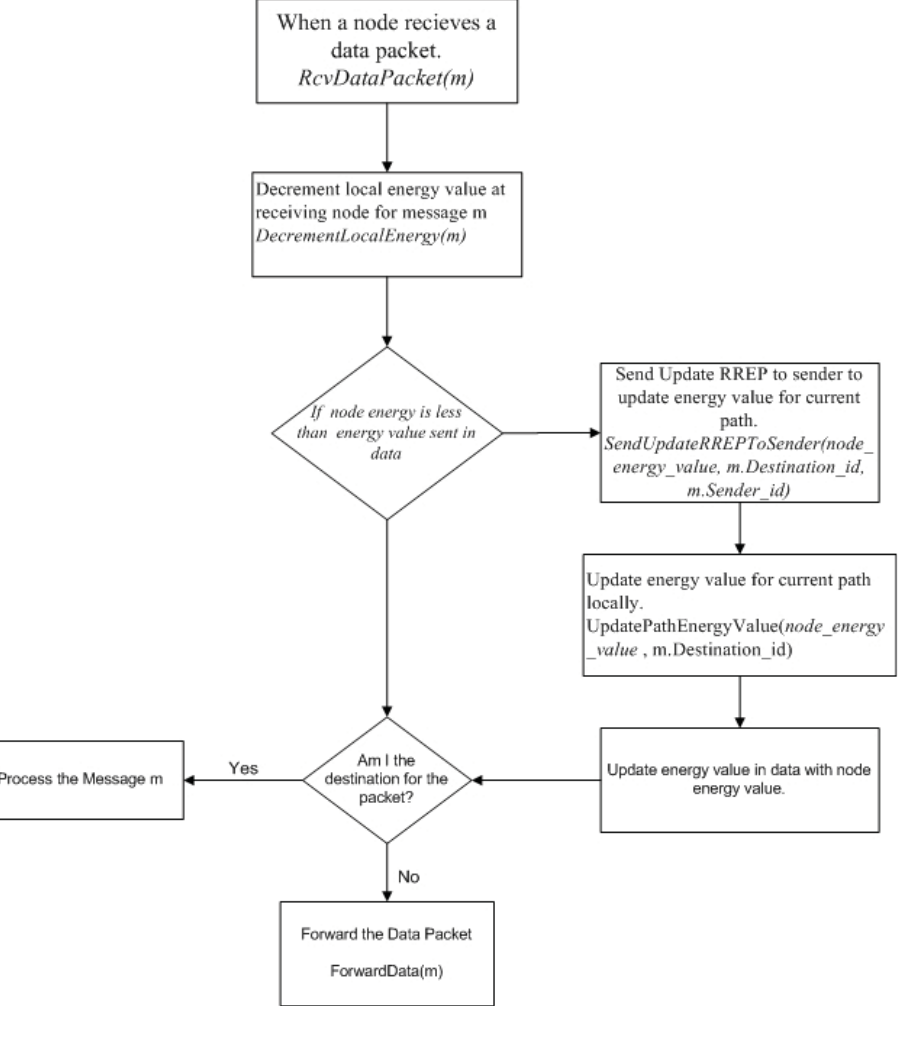
Figure 9. Overall procedure for intermediate node to receive data